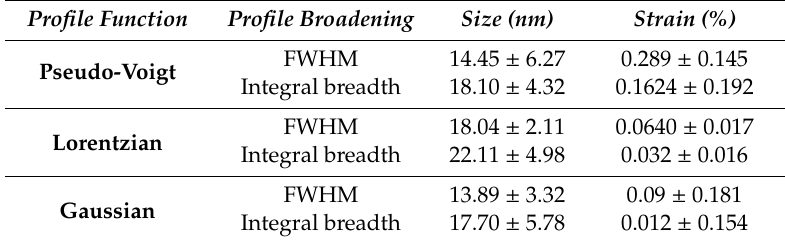
Table 2. Crystallite size and strain calculated from pseudo-Voigt, Lorentz, and Gauss methods.